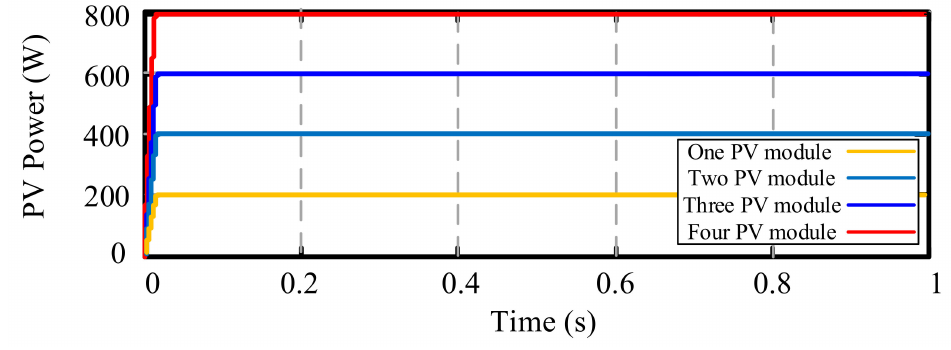
Figure 12. PV power curve for different PV modules at the normal operating